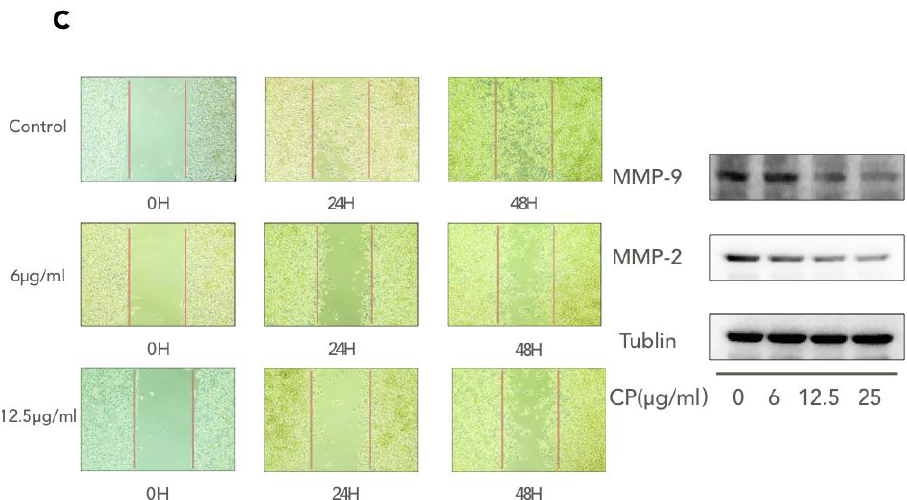
Figure 3. Chinese propolis (CP) suppressed melanoma progression by targeting NLRP1. ( A ) CP inhibited inflammation in human melanoma by targeting NLRP1. The NLRs and related proteins were analyzed by Western blot. In contrast to protein level, NLRP1 mRNA level was up-regulated; ( B ) The effect of CP on the IL-1 family was measured by qRT-PCR. The mRNA expressions of IL-1 α , IL- β and IL-18 were all decreased significantly after treatment with CP. The ROS level in human melanoma was also downregulated by CP treatment. * p < 0.05, ** p < 0.005 and *** p < 0.001 for the designated treatment versus the control (vehicle). Each value represents the mean ± SEM for n = 6; ( C ) CP suppressed migration of human melanoma. A375 cells were treated with different concentrations of CP (6 µ g/mL and 12.5 µ g/mL). The migration ability was determined by the wound healing assay and images were obtained by a live imaging microscope every 12 h. The activity and abundance of MMP-9 and MMP-2 of A375 cells treated with different concentration of CP (0, 6, 12.5, 25 µ g/mL) for 48 h was determined by Western blot analysis.